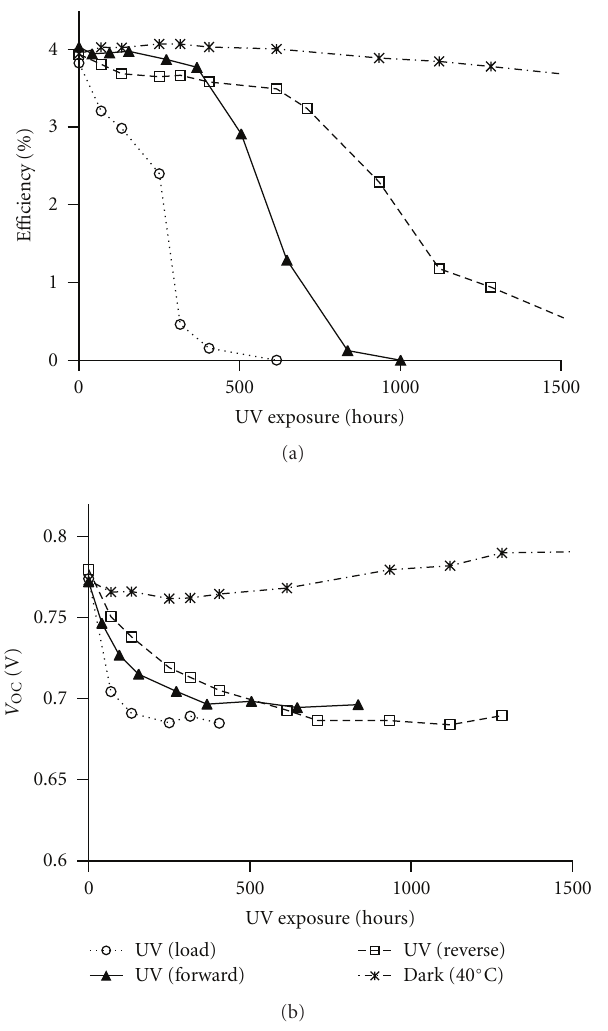
Figure 4: Change in (a) % η and in (b) V OC over the UV-exposure period. There is a clear order of cell degradation whereby cells under load and illuminated from the WE side fail before those under opencircuit (also illuminated from the WE side) which fail faster than those under opencircuit and illuminated from the CE side. Data is also shown for cells under opencircuit and kept in the dark for the exposure period.